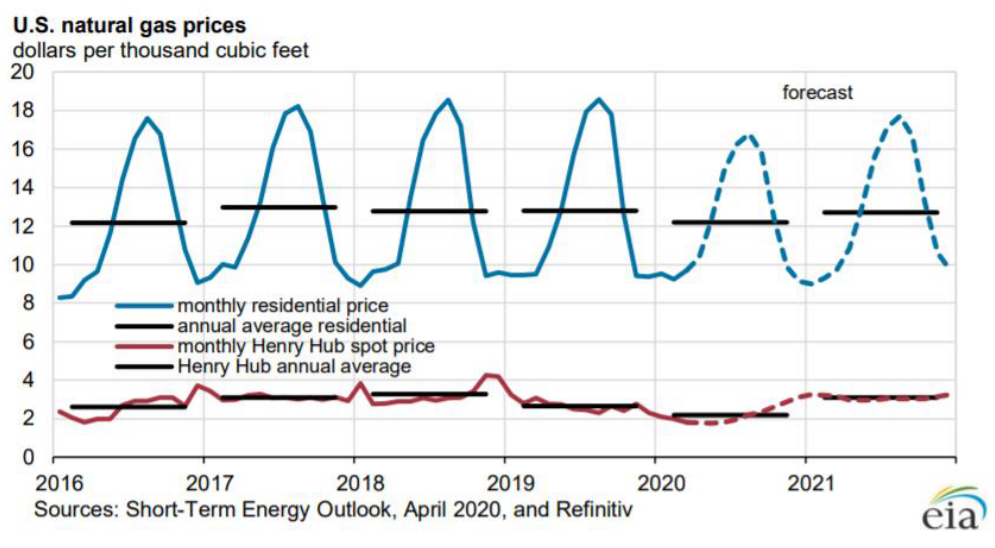
Figure 3. Henry Hub natural gas spot price (2016–2021). Reproduced from U.S. Energy Information